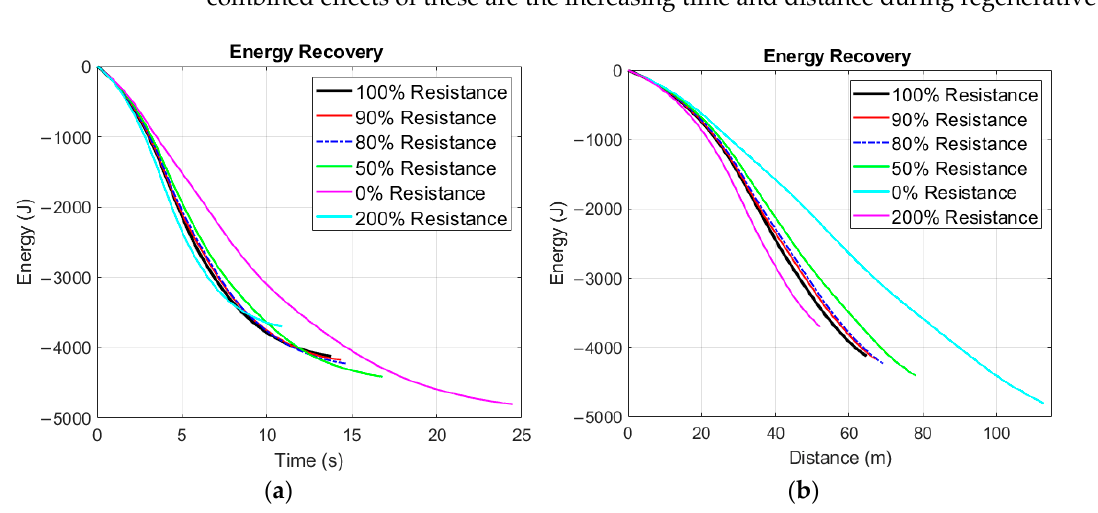
Figure 10. Energy recovery in the case for varied resistance force optimization attempts: ( a ) energy– time display; ( b ) energy–distance display.